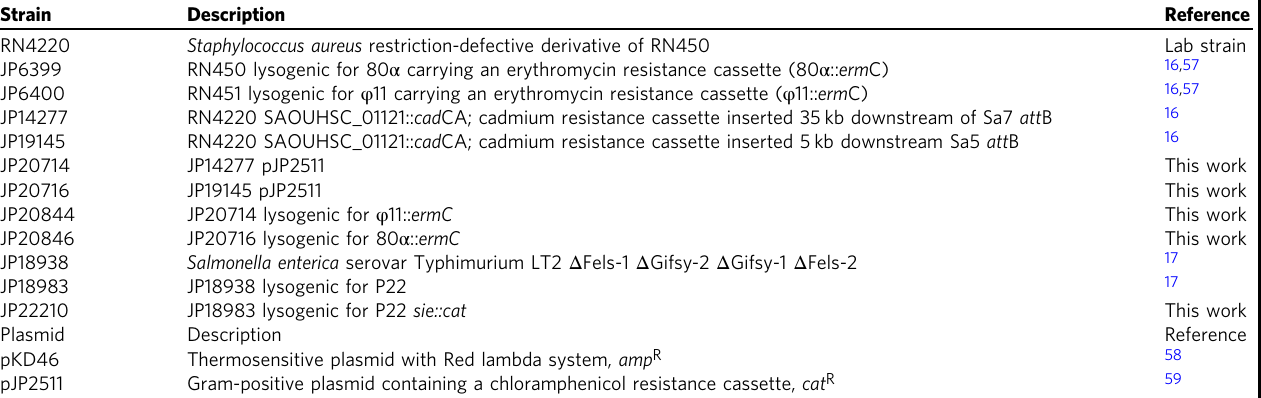
Table 5 Bacterial strains and